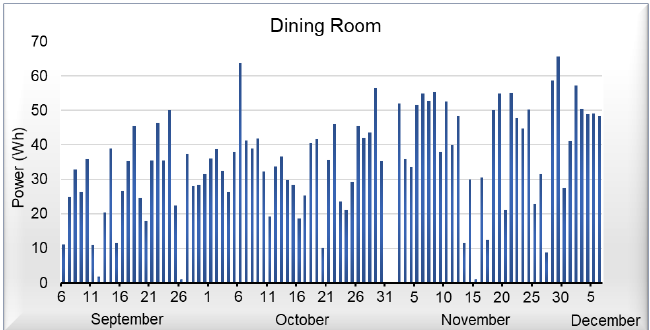
Figure 11. Power consumed by the living room light.